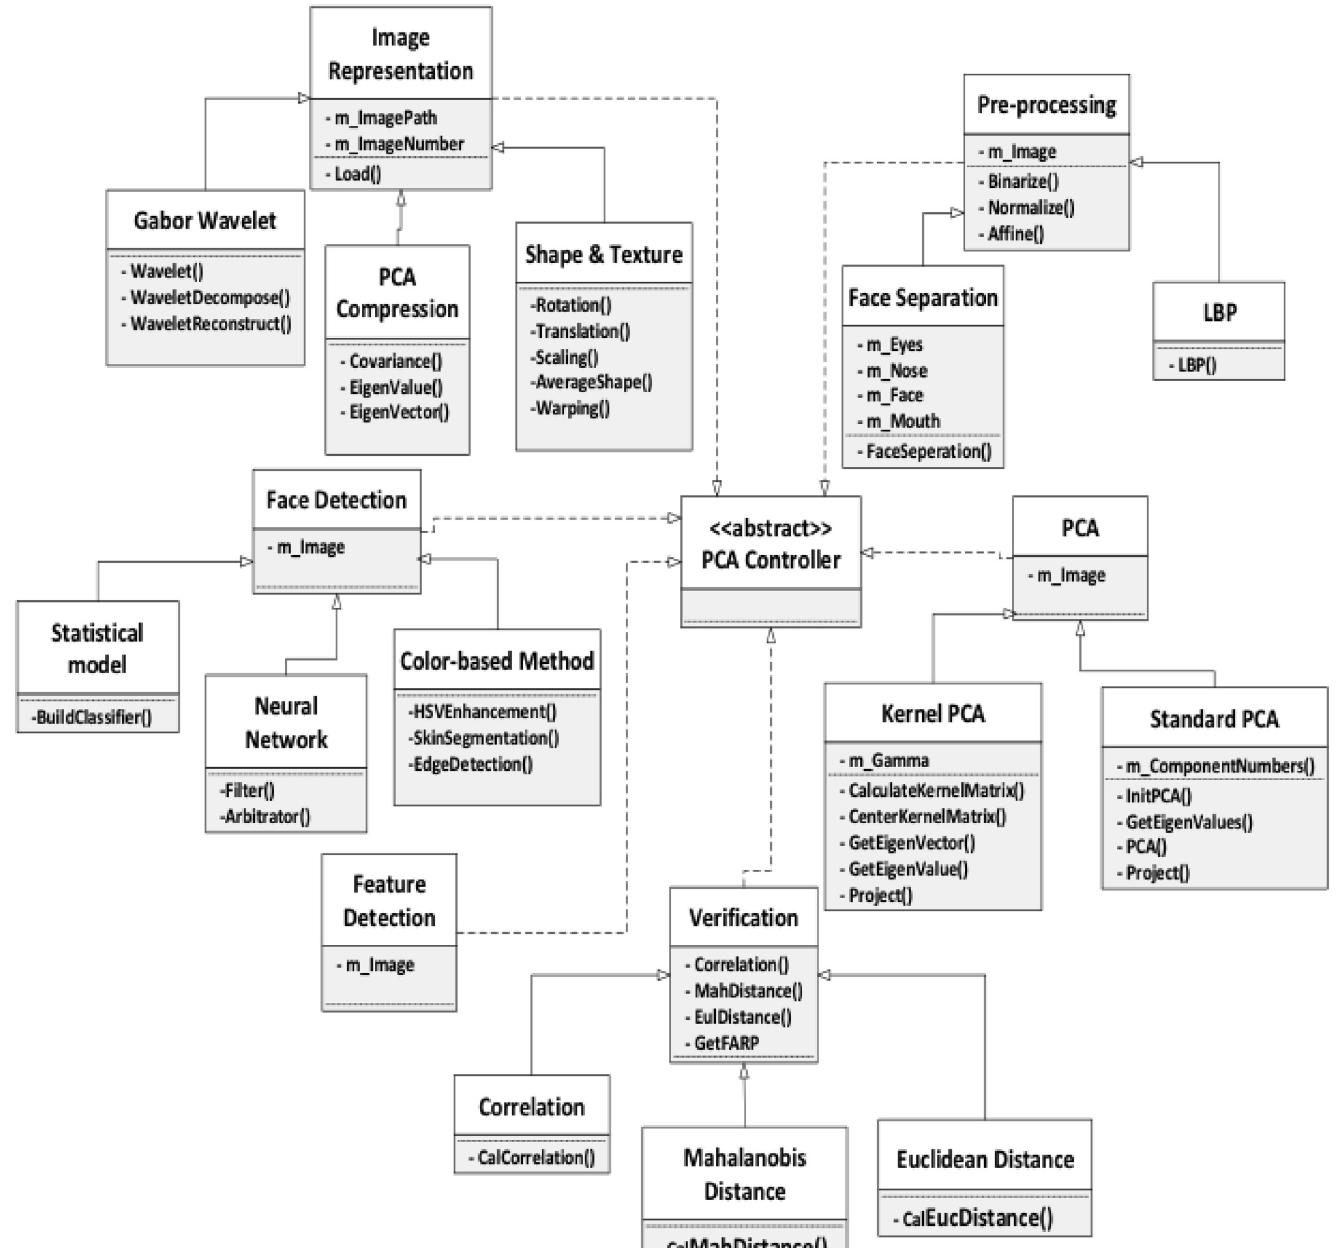
Fig 7. Framework design